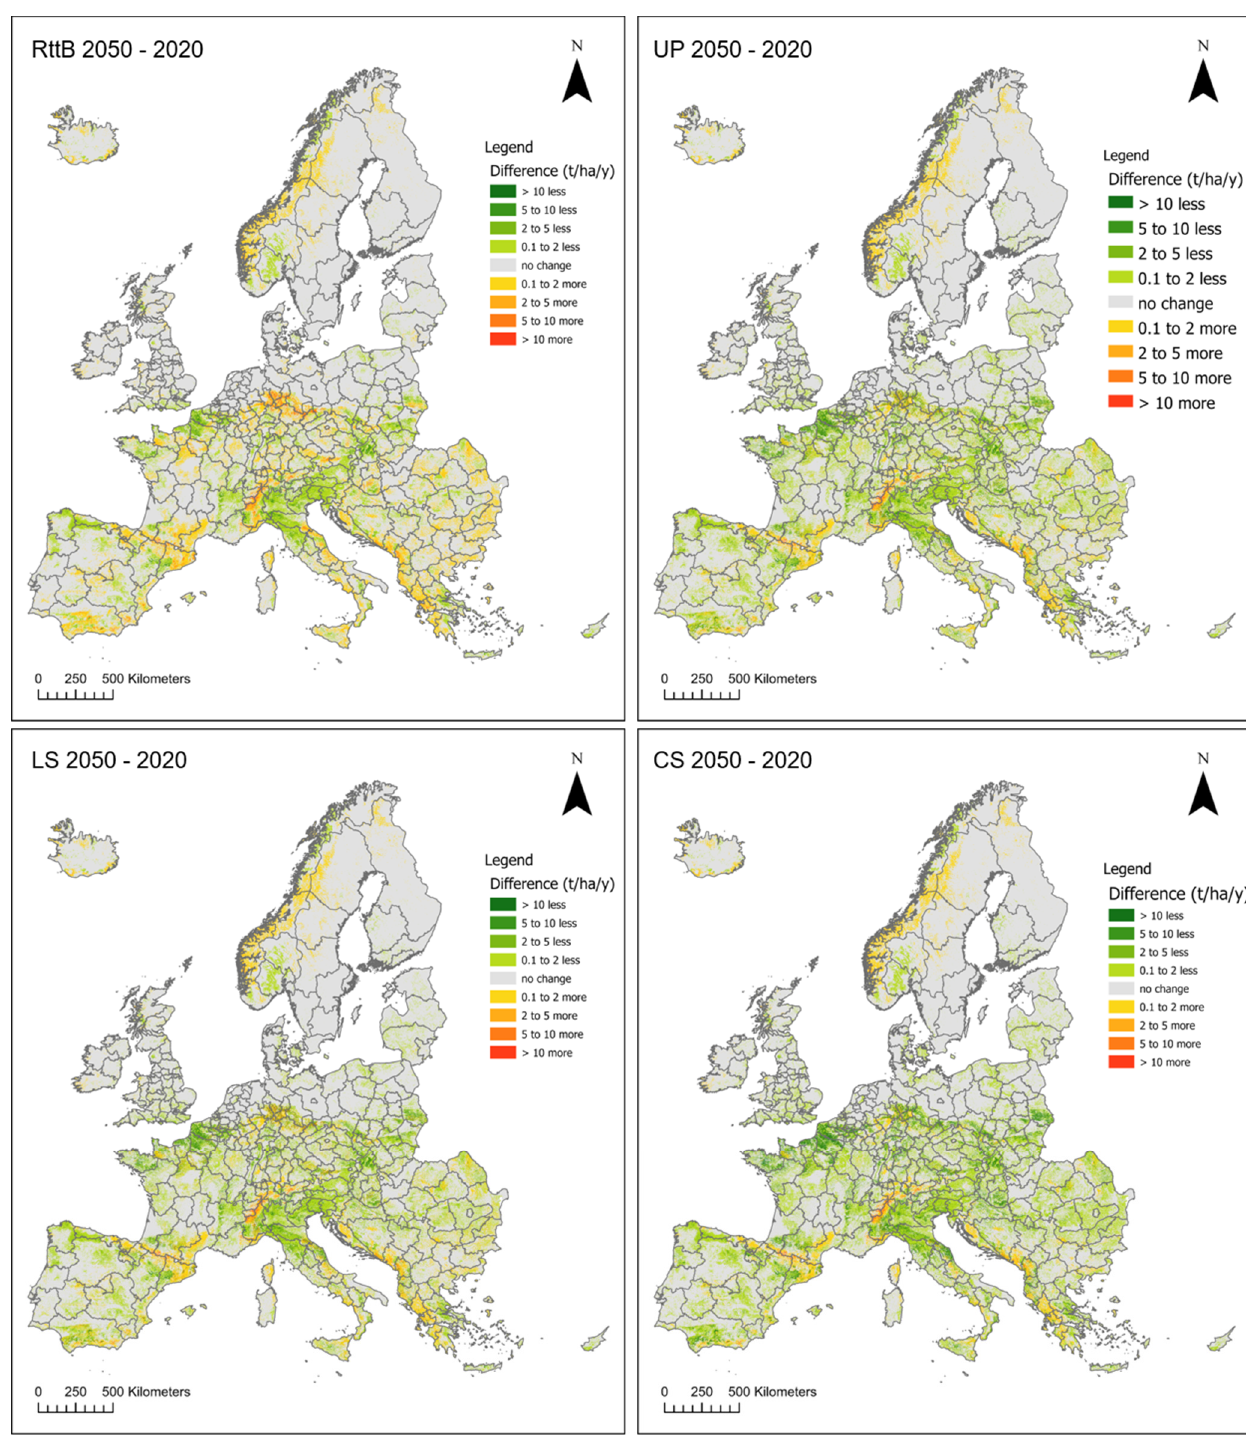
Figure 9. Simulated difference in erosion (t/ha/y) between 2020 and 2050 for each scenario.